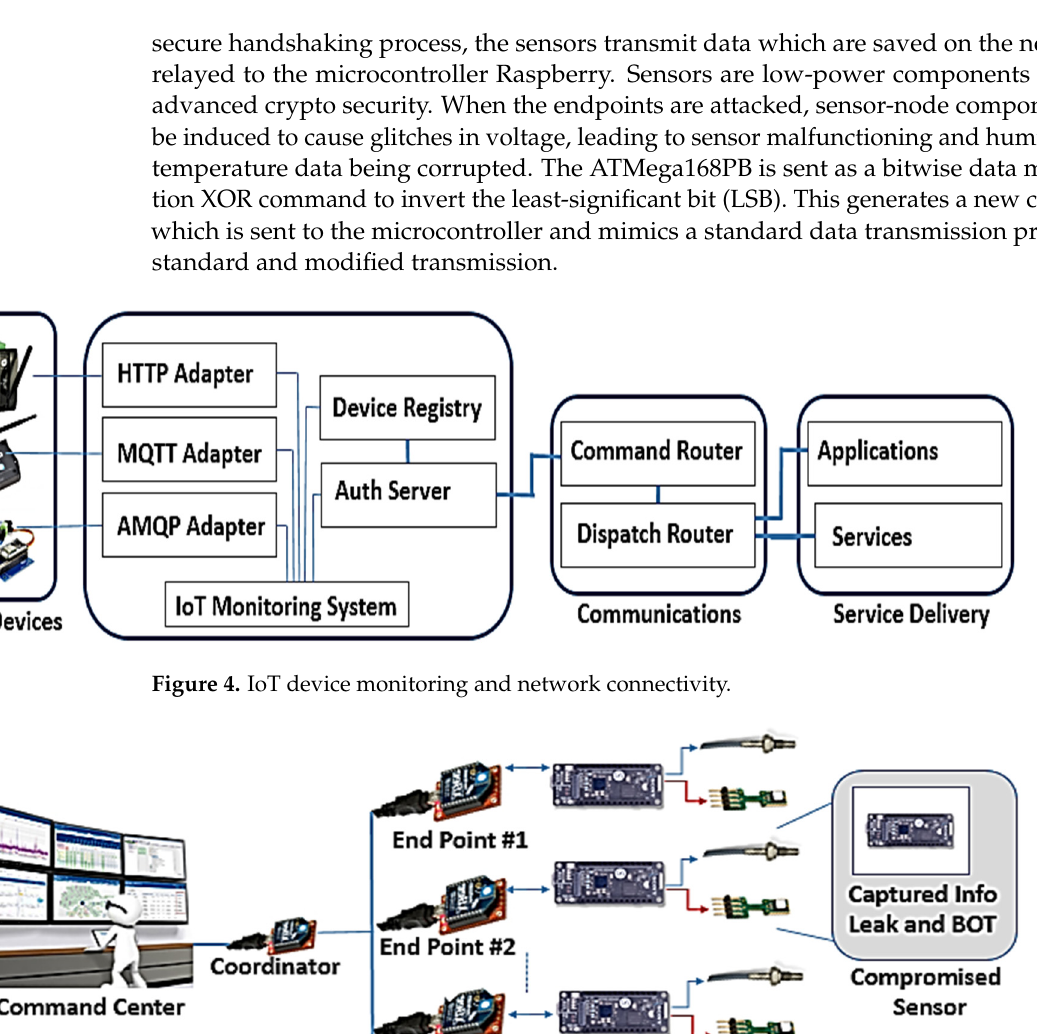
Figure 4. IoT device monitoring and network connectivity.